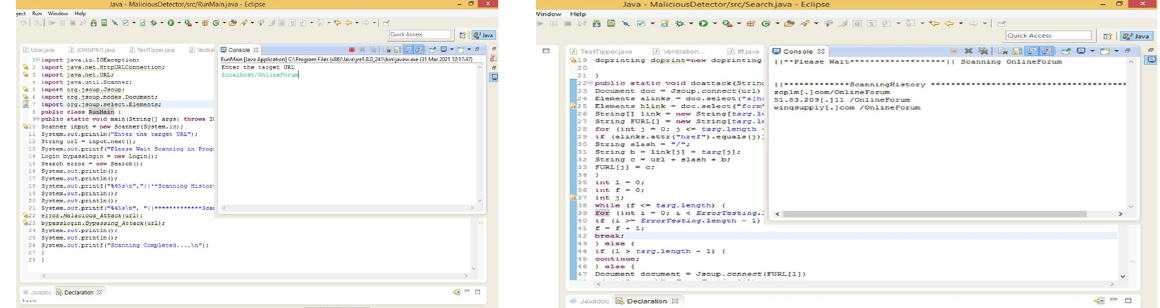
Fig. 6. Input of Online Forum application Fig. 7. Output scanning result of Online Forum application